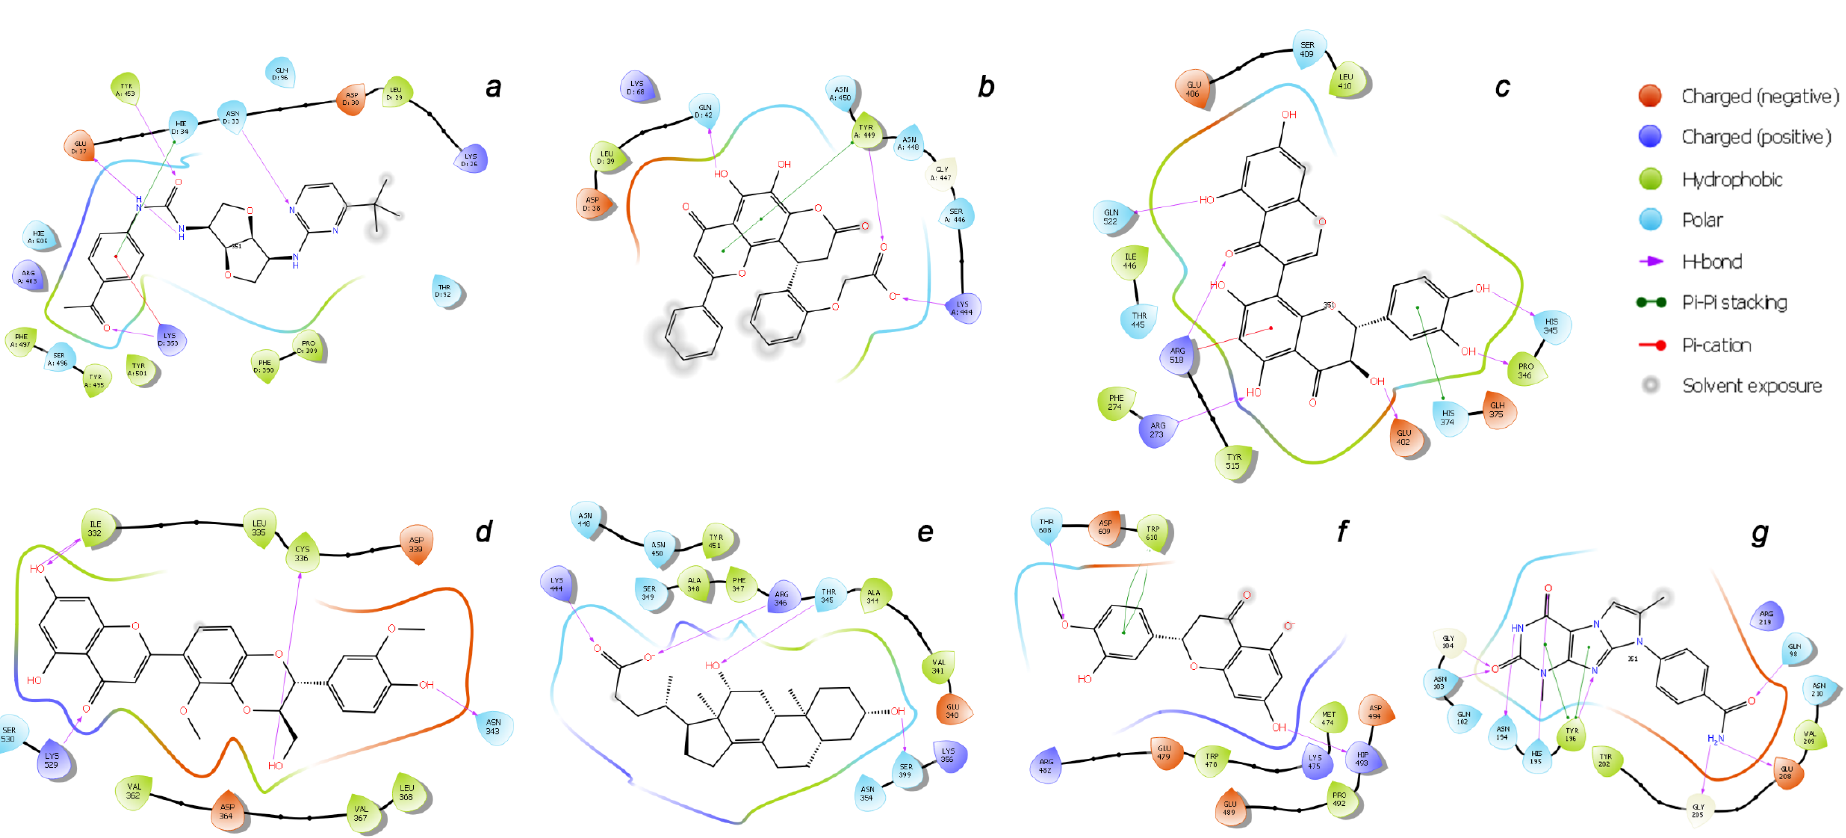
Figure 9. 2D binding interaction diagrams of the top-ligands inside the ( a – g ) active sites of RBD–ACE2 (PDB ID: 7T9L).